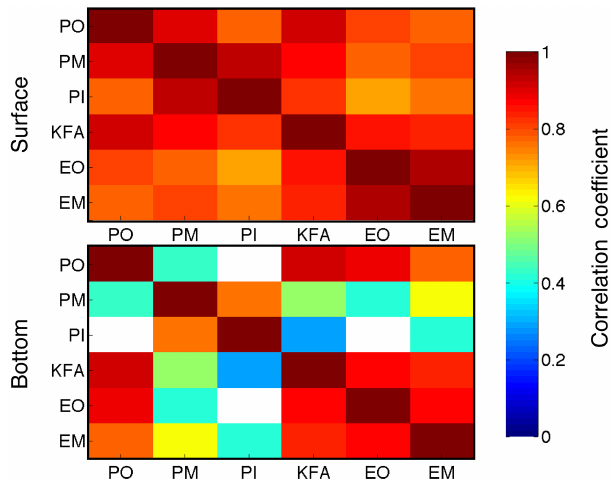
Figure 10. Correlation heat maps of (cid:127) Ar for the full year. Top panel shows correlations between surface sites, and the bottom panel shows correlations between bottom sites. Site names are ab- breviated on both panels and correspond to the order presented in the legend of Fig. 9a. Blank spaces show statistically insignificant ( p> 0 . 05) correlations.